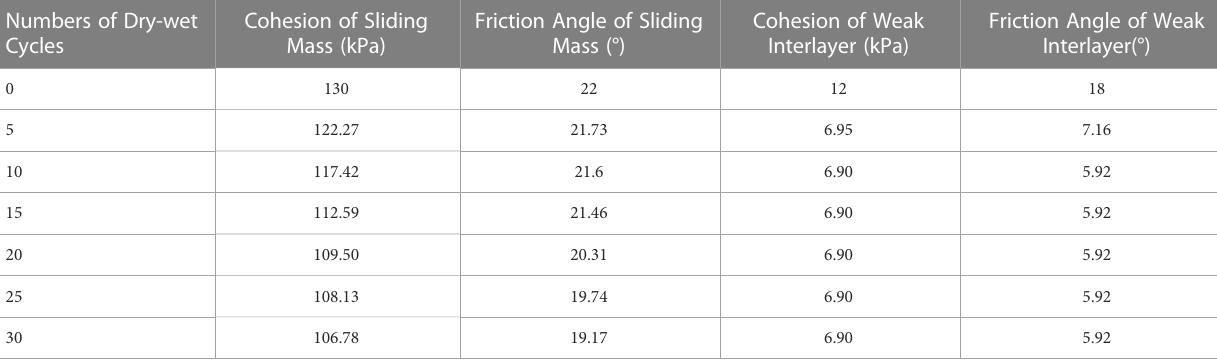
TABLE 4 Mechanical parameters of sliding mass and weak interlayer with different dry-wet cycles. Numbers of